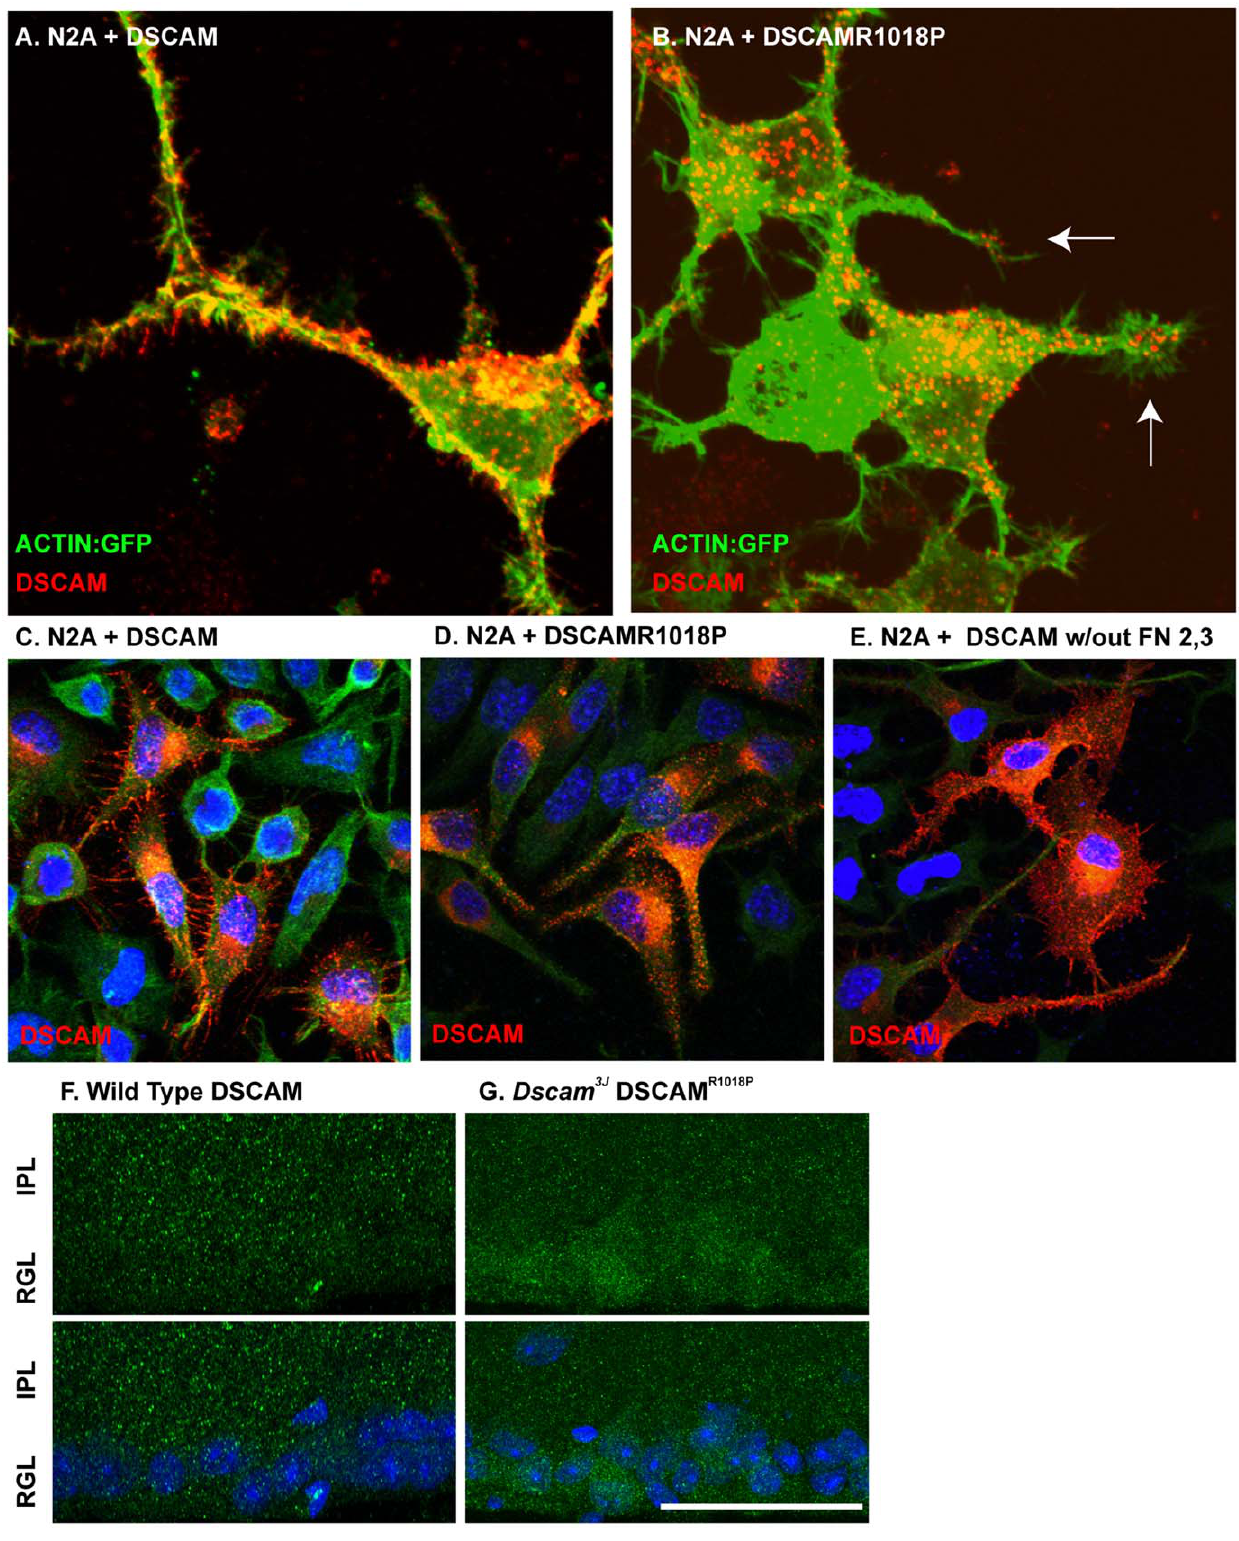
Figure 6. Dscam 3J mutation inhibits filopodial localization of DSCAM. A – C , Dscam expression constructs were transfected into N2A Cells. A , Full length canonical DSCAM is abundant in the golgi-ER, where it is translated and trafficked, along the membrane and at the tips of filopodia. B , DSCAM R1018P is translated and trafficked in and from the golgi-ER and appears in trafficking vesicles within growth cones but does not appear to be localized to the filopodia. C , The localization defect in DSCAM R1018P is not a result of disrupted fibronectin domain function, as deletion of the second and third fibronectin domain of DSCAM does not interfere with filopodial localization. D and E , DSCAM or DSCAM R1018P were transfected into N2A